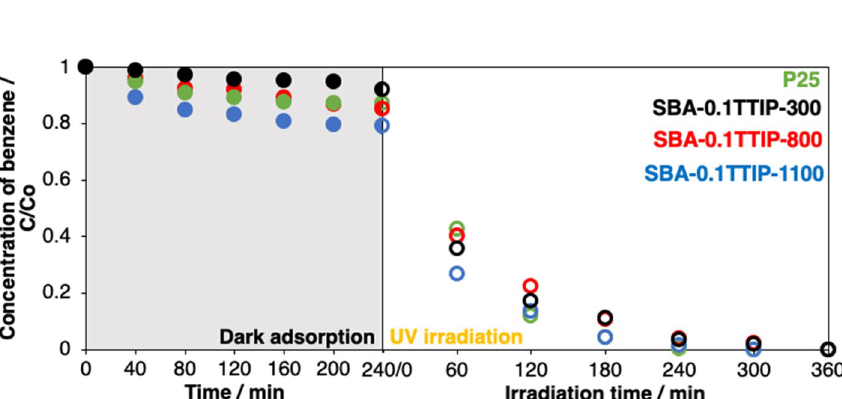
Figure 11. Changes in the relative concentration (C/C 0 ) of benzene under the dark adsorption and the UV irradiation. The initial concentration (C 0 ) of benzene was 300 ppm.